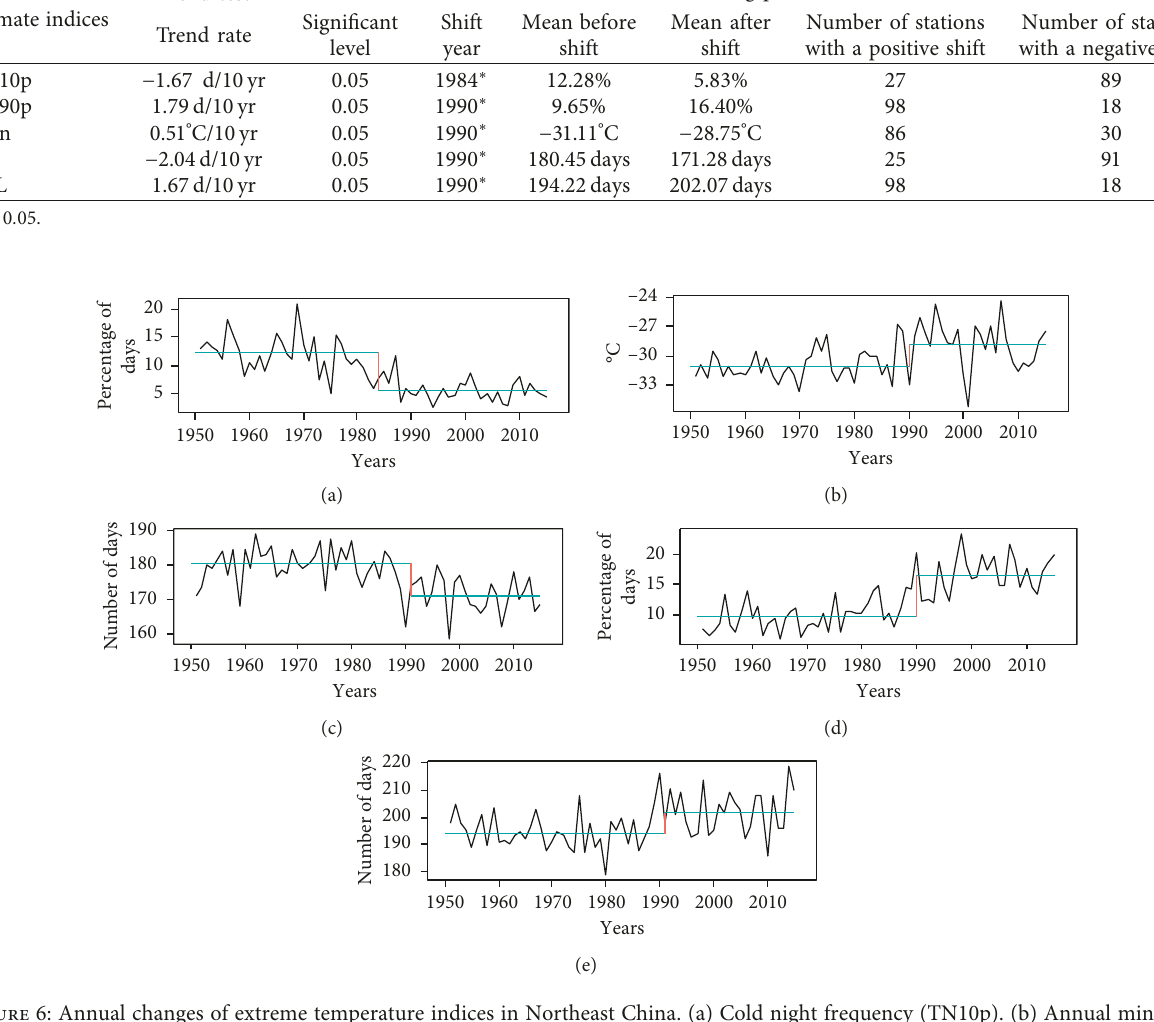
Table 5: Analysis results of changing points of the climate extreme indices in Northeast China. Climate